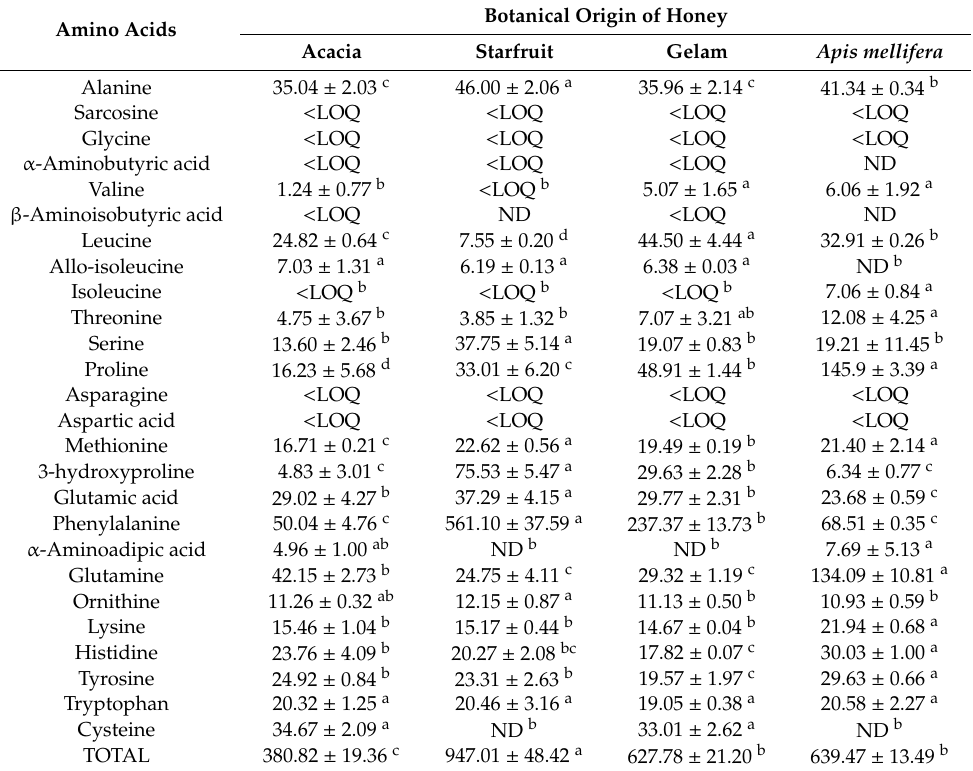
Table 3. Amino acids profile and concentration (mg / kg) in honey samples from di ff erent botanical